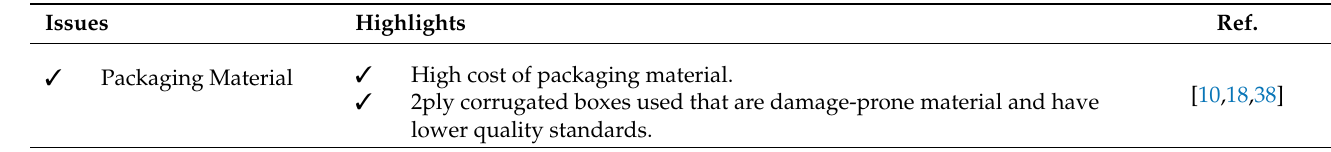
Table 6. Accumulated packaging issues in the value chain of kiwi in Bageshwar District and strategies and solutions implemented. [Ref to supplementary sheet for Figures S1 and